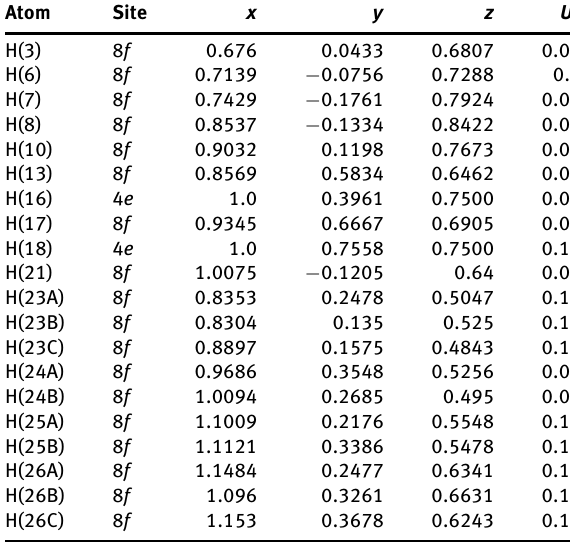
Table 2: Fractional atomic coordinates and isotropic or